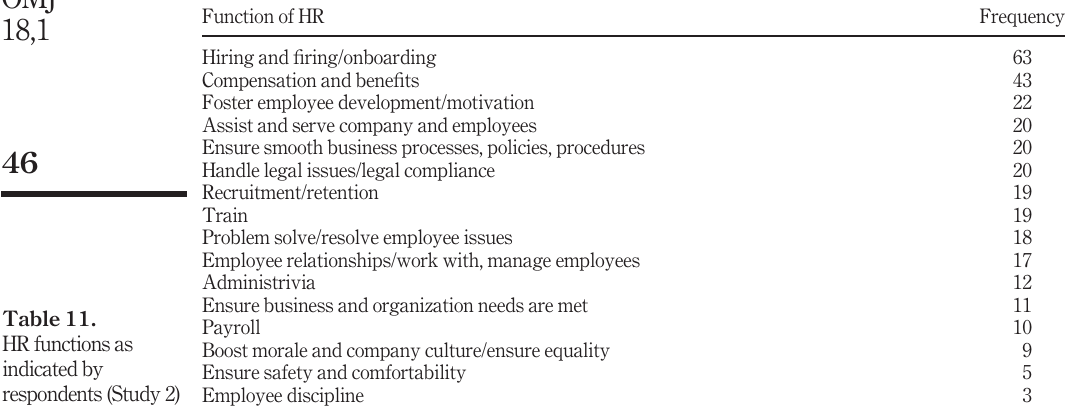
Table 11. HR functions as indicated by respondents (Study